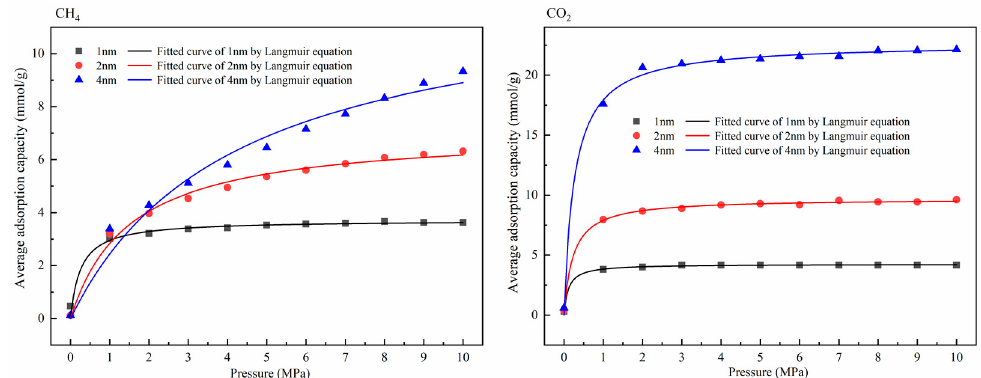
Figure 4. Adsorption isotherms of CH 4 and CO 2 at 293.15 K.